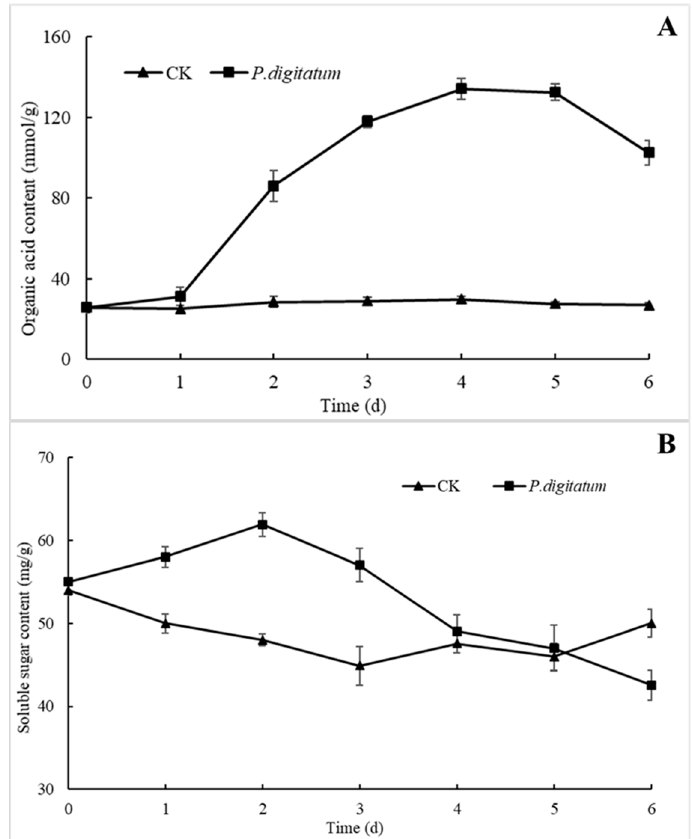
Figure 5. Effects of P. digitatum on biochemical changes of citrus wound tissues at 25 °C . ( A ): Organic acid; ( B ): soluble sugar. CK: Citrus inoculated with water. Bars represent the standard deviation of the mean.